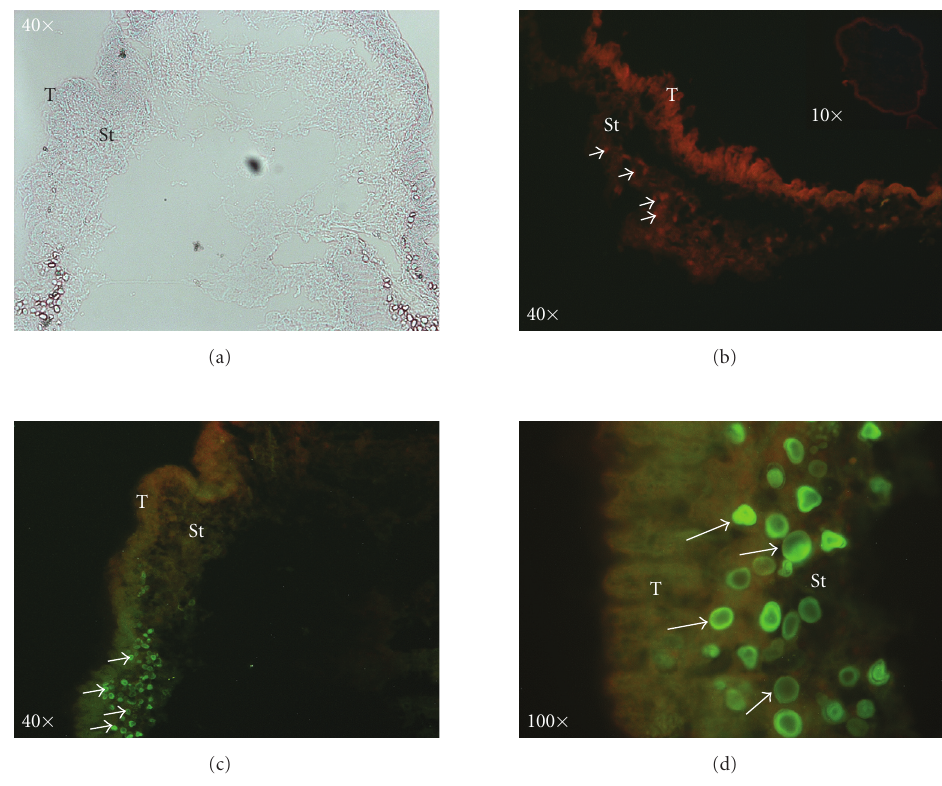
Figure 5: ERK-like location in Taenia crassiceps by immunocytochemistry. (a) Transversal section of one T. crassiceps cysticercus where tegument, subtegument, and cells are observed with no staining. (b) Parasite cross-section incubated with FITC-conjugated goat anti-rabbit antibody, as staining control. Nonreacting cells are shown in red at 10 × and 40 × . Unspecific detection of ERK-like was not observed during our experiments. (c) Specific detection of ERK-like (green fluorescent) was located in parasite cells mainly disposed along subtegument tissue, 40 × . (d) A magnification of 100 × shows in detail the T. crassiceps cells expressing ERK-like exclusively on subtegument tissue. T = Tegument tissue; St = Subtegument tissue.